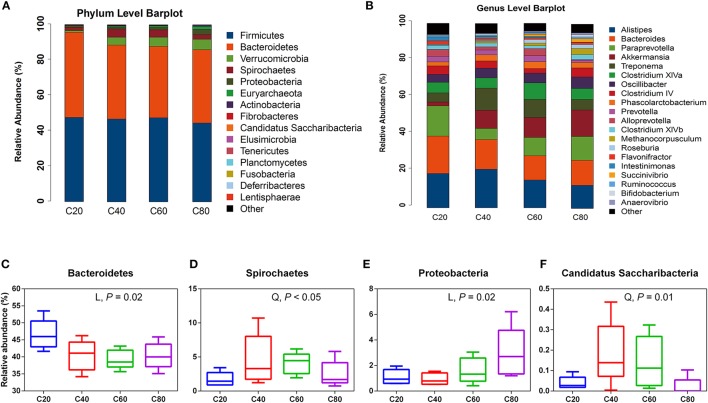
Fecal bacterial phyla and genera in four treatments. (A) The bacterial taxonomic composition of fecal samples from the four treatments at the phylum level. (B) The bacterial taxonomic composition of fecal samples from the four treatments at the genus level (top 20, according to relative abundance). The significantly changed bacterial phyla Bacteroidetes
(C), Spirochaetes
(D), Proteobacteria
(E), and Candidatus Saccharibacteria
(F) among treatments. The small box plots show the 25, 50, and 75th percentiles, with whiskers showing the extremes of the data. L, changed linearly; Q, changed quadratically. C20, diet containing 20% of concentrate; C40, diet containing 40% of concentrate; C60, diet containing 60% of concentrate; C80, diet containing 80% of concentrate.